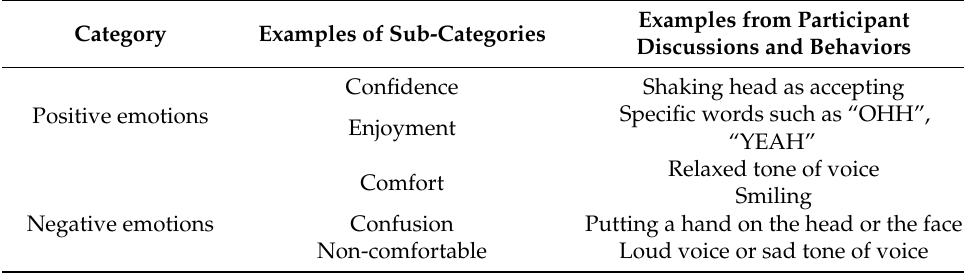
Table 1 exemplifies the analysis process of the participants’ emotions. Table 1. Examples of analyses of the participants’